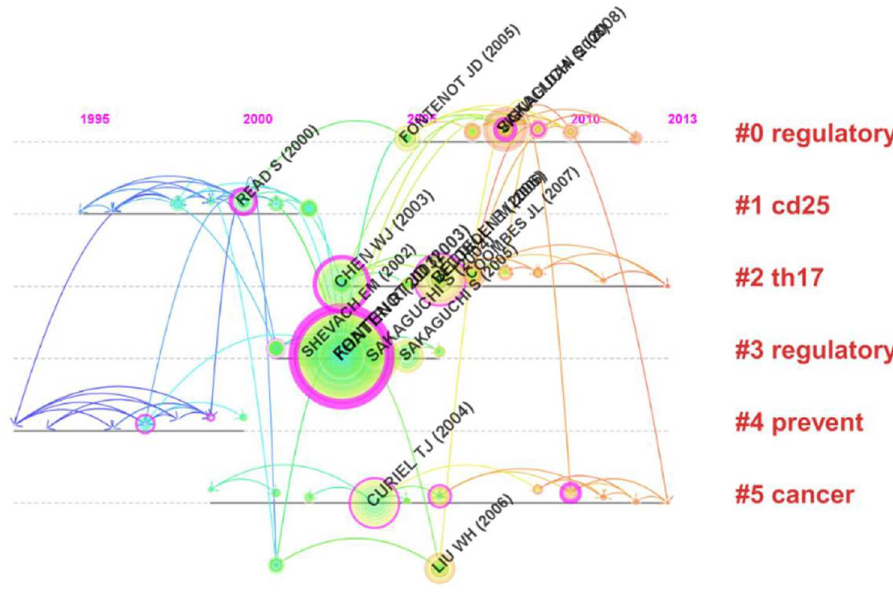
Fig 7. Reference co-citation time-viewmap of articlesrelatedto regulatoryT cell (Treg) research published from 2000 to 2015.